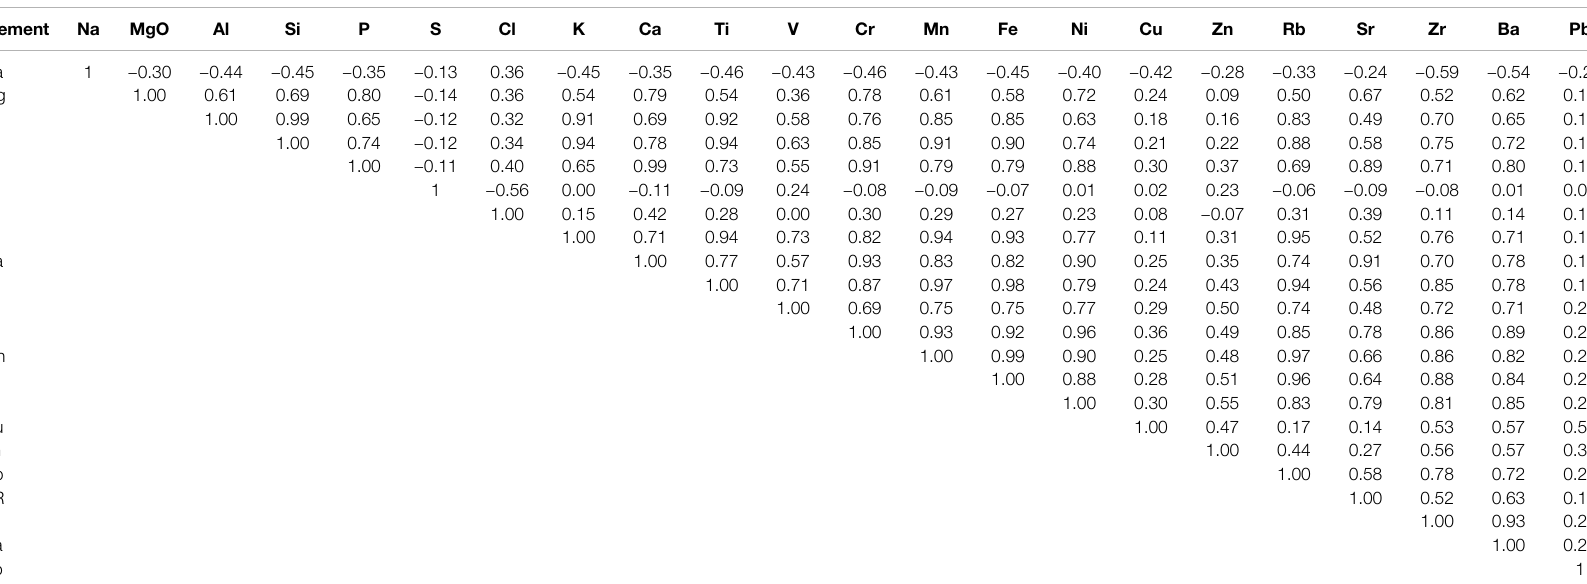
TABLE 1 | Correlations among detected elements in PM 10